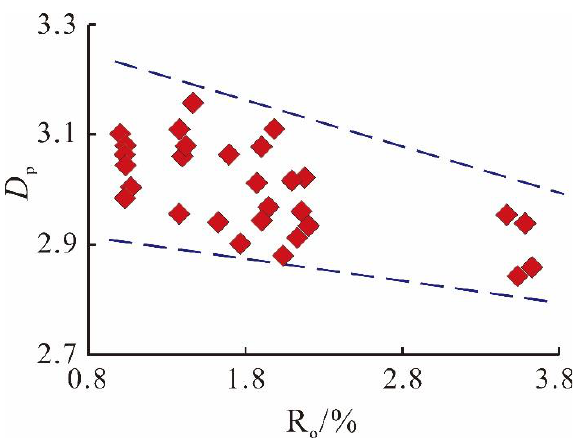
Minerals 2022 , 12 , x FOR PEER REVIEW Figure 3. Relationship between percolation fractal dimension ( D p ) and vitrinite reflectance (R o ). Figure 3. Relationship between percolation fractal dimension ( D